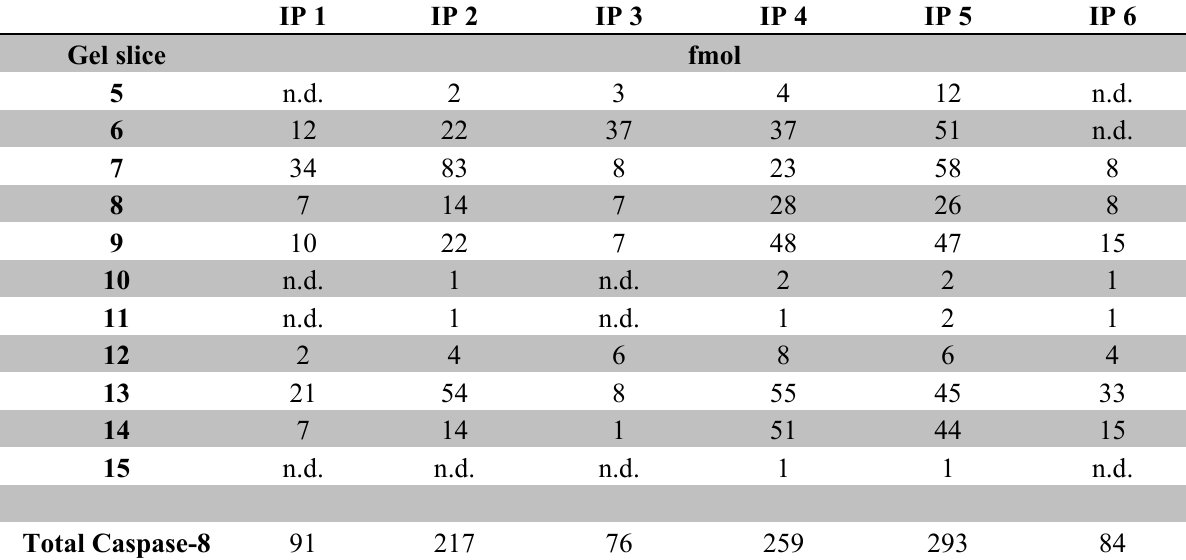
Table 2. Quantification of caspase-8 in different gel slices and total amounts in the six DISC